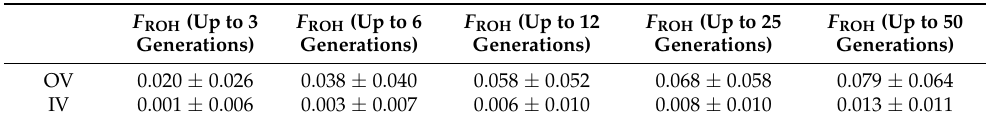
Table 1. Summary statistics of the genomic inbreeding coefficients ( F ROH ) in the Original Valachian (OV) and Improved Valachian (IV)